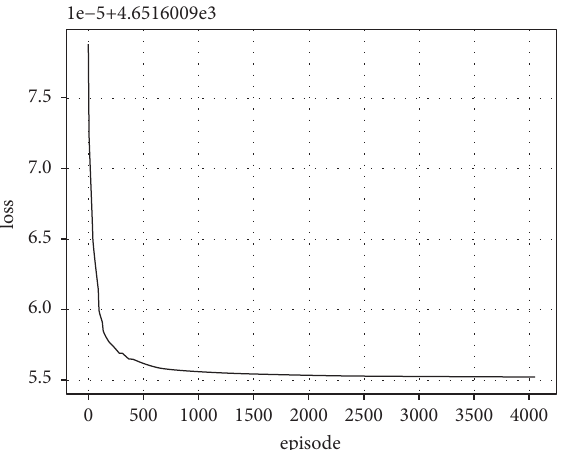
Figure 13: The loss value variation of 4080 episodes based on BP-DNN.